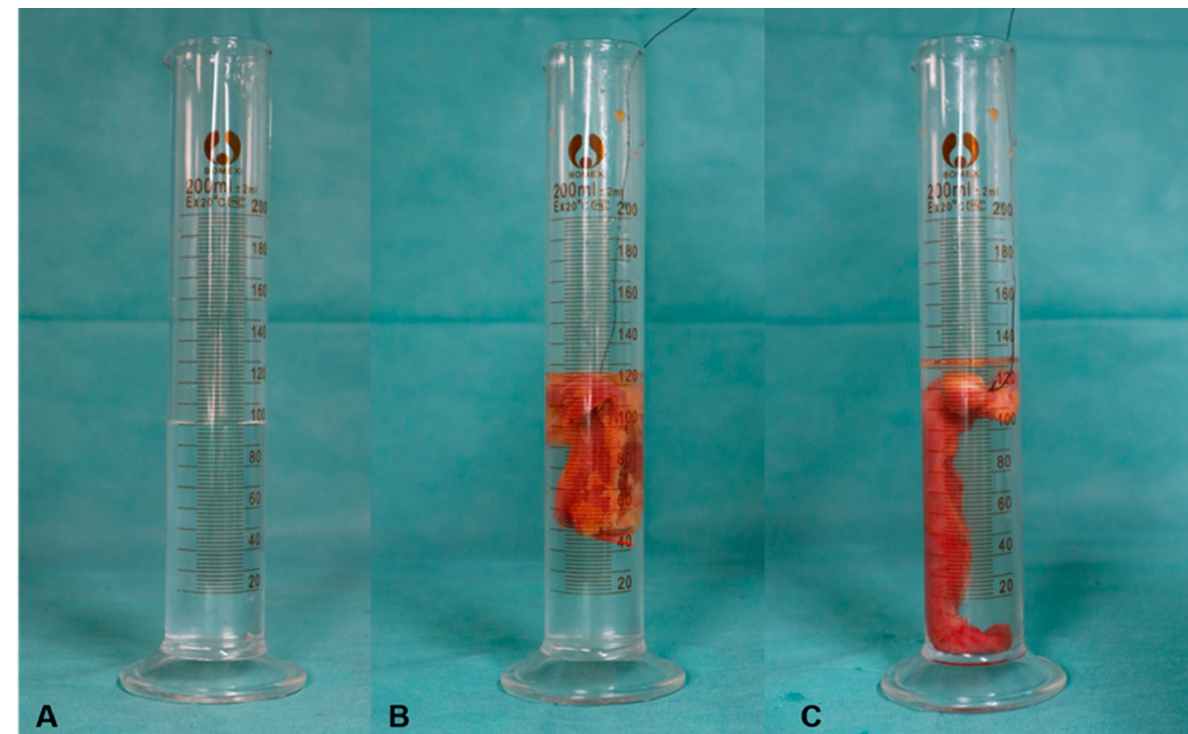
Figure 4. Photos showing how to measure the volume of two flap A volumetric cylinder filled with 100 mL of water before each measurement ( A ), then SAF ( B ), and ALF ( C ), and were submerged in water totally separately reading as 126 mL and 134 mL. The volume of SAF is 26 mL and that of ALF is 34 mL.